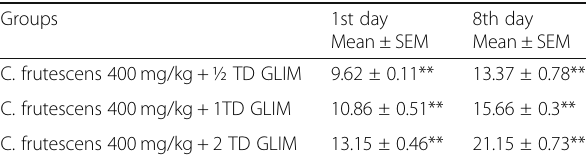
Table 5 Serum insulin levels on Single and repeated dose administration of C. frutescens and glimepiride in diabetic rats (chemi-luminescent immune assay method) Groups